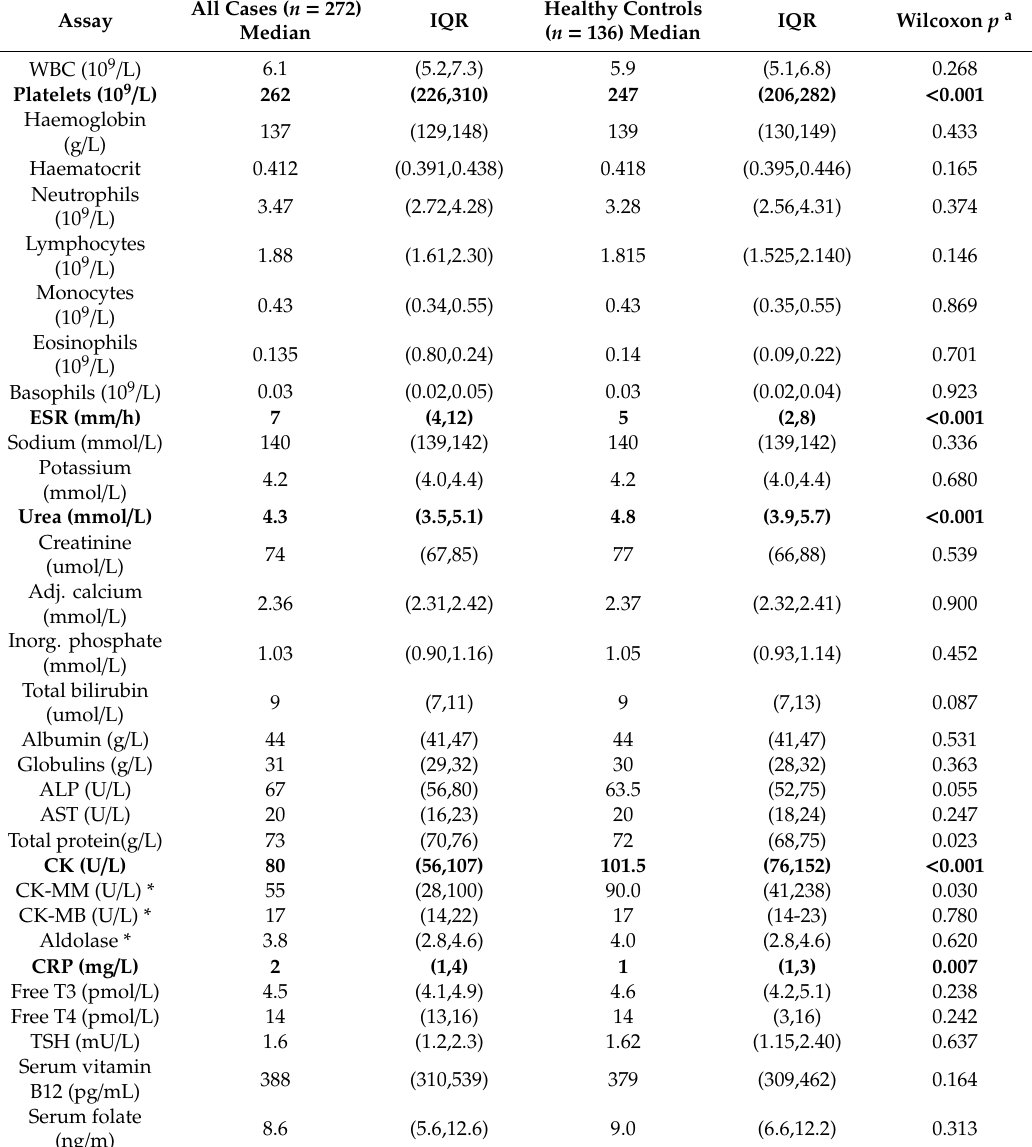
Table 2. Comparison of baseline laboratory haematological and biochemical test results from ME / CFS cases and healthy